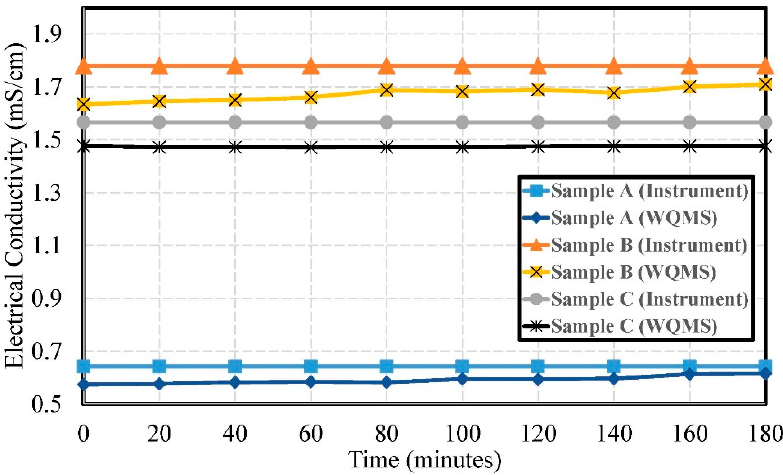
Figure 12. The experimental results of the electrical conductivity by using Samples A, B, and C.